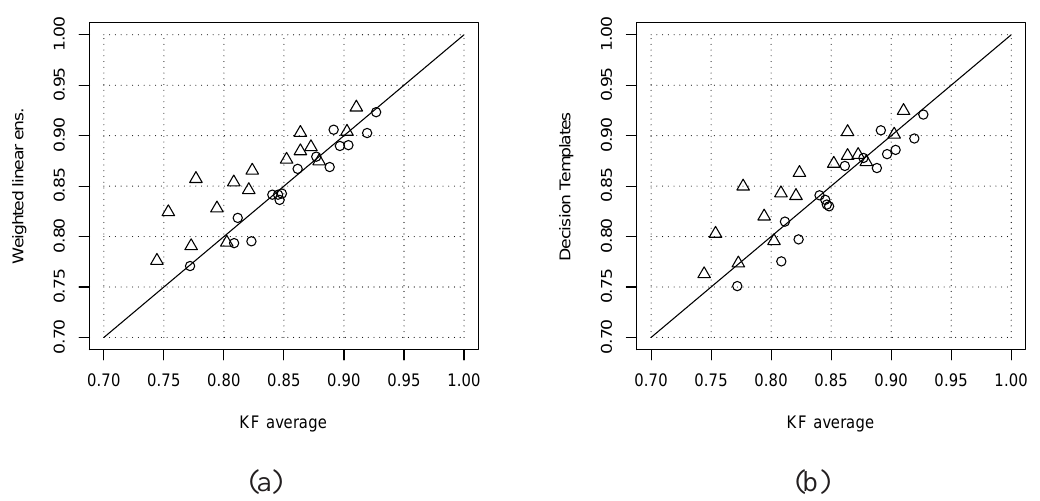
Figure 4: Experiments with 6 no-noisy and 6 noisy data sets. Points represent the AUC score of kernel fusion (abscissa) and ensemble (ordinate) methods for 15 FunCat functional classes. Circular points: results with no-noisy data. Triangular points: results with noisy data. (a) Average KF vs Weighted ensembles (b) Average KF vs Decision